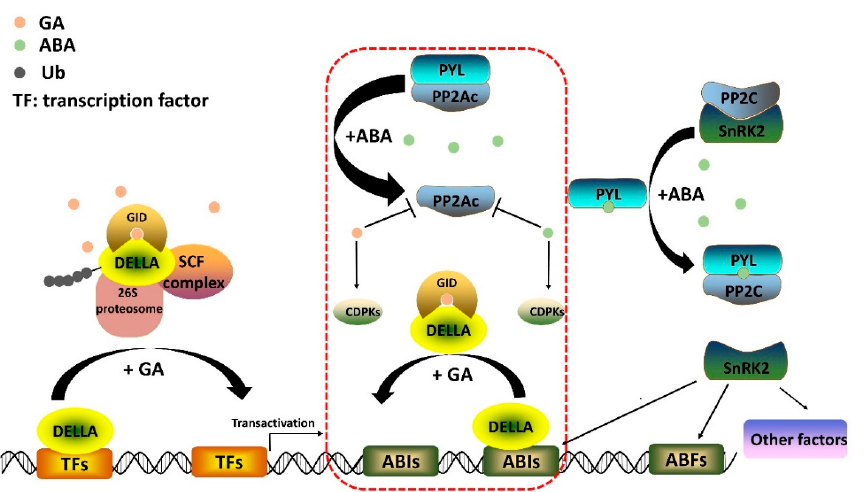
Figure 2. The potential GA and ABA signaling during stem/root tuber development. Arrows and linkers represent positive and negative effects, respectively. The components encircled by a red dotted rectangle line indicate the potential protein factors in both core GA and ABA signaling.